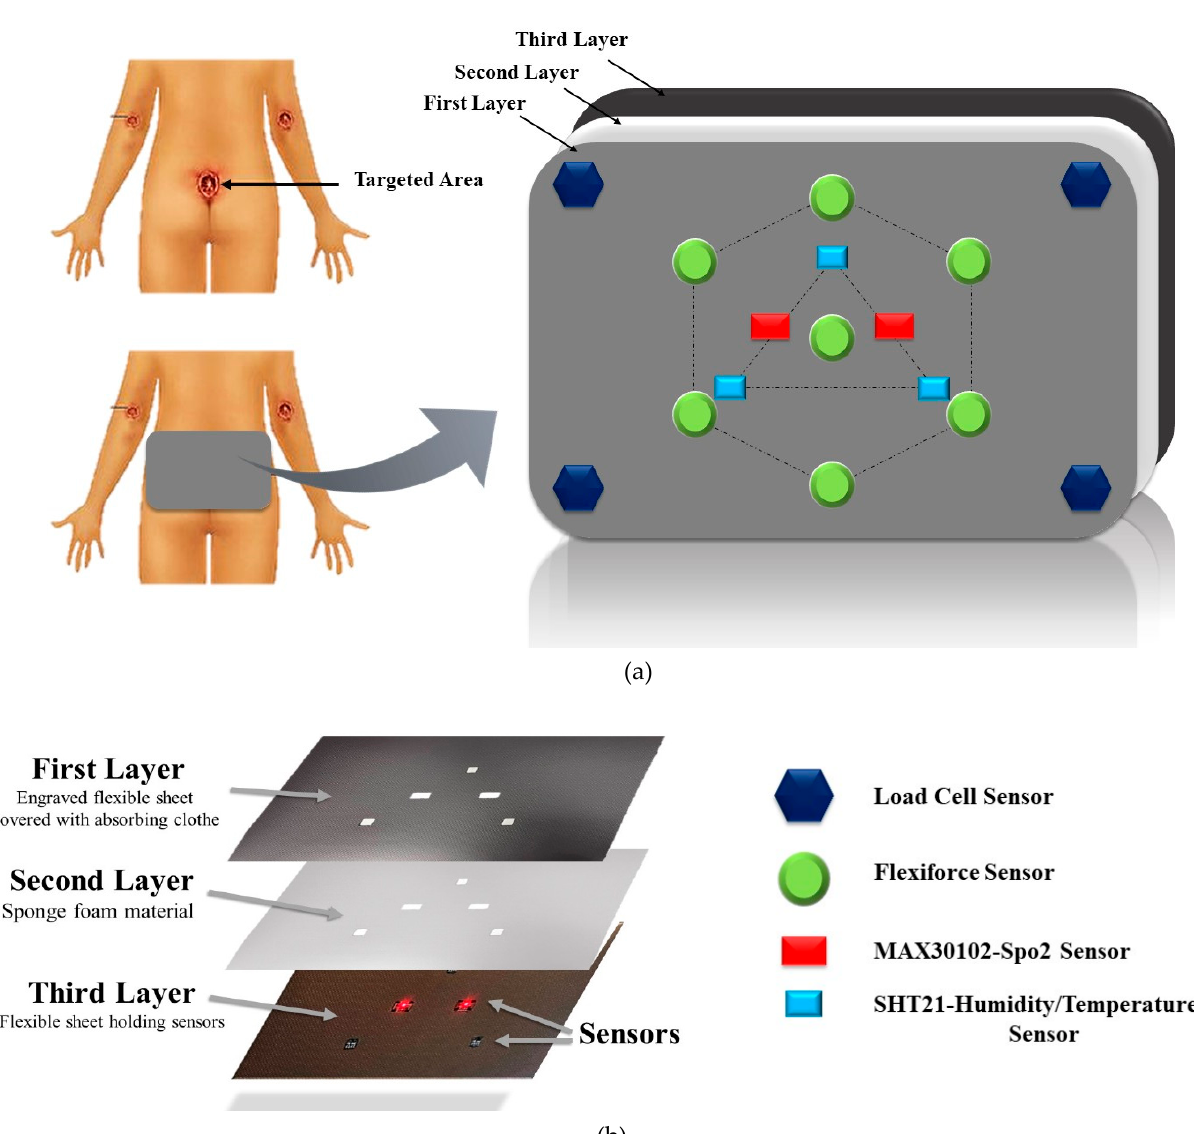
Figure 2. ( a ) Shape and location of the ulcer-sensing device over the targeted area. ( b ) Design of the ulcer-sensing pad.